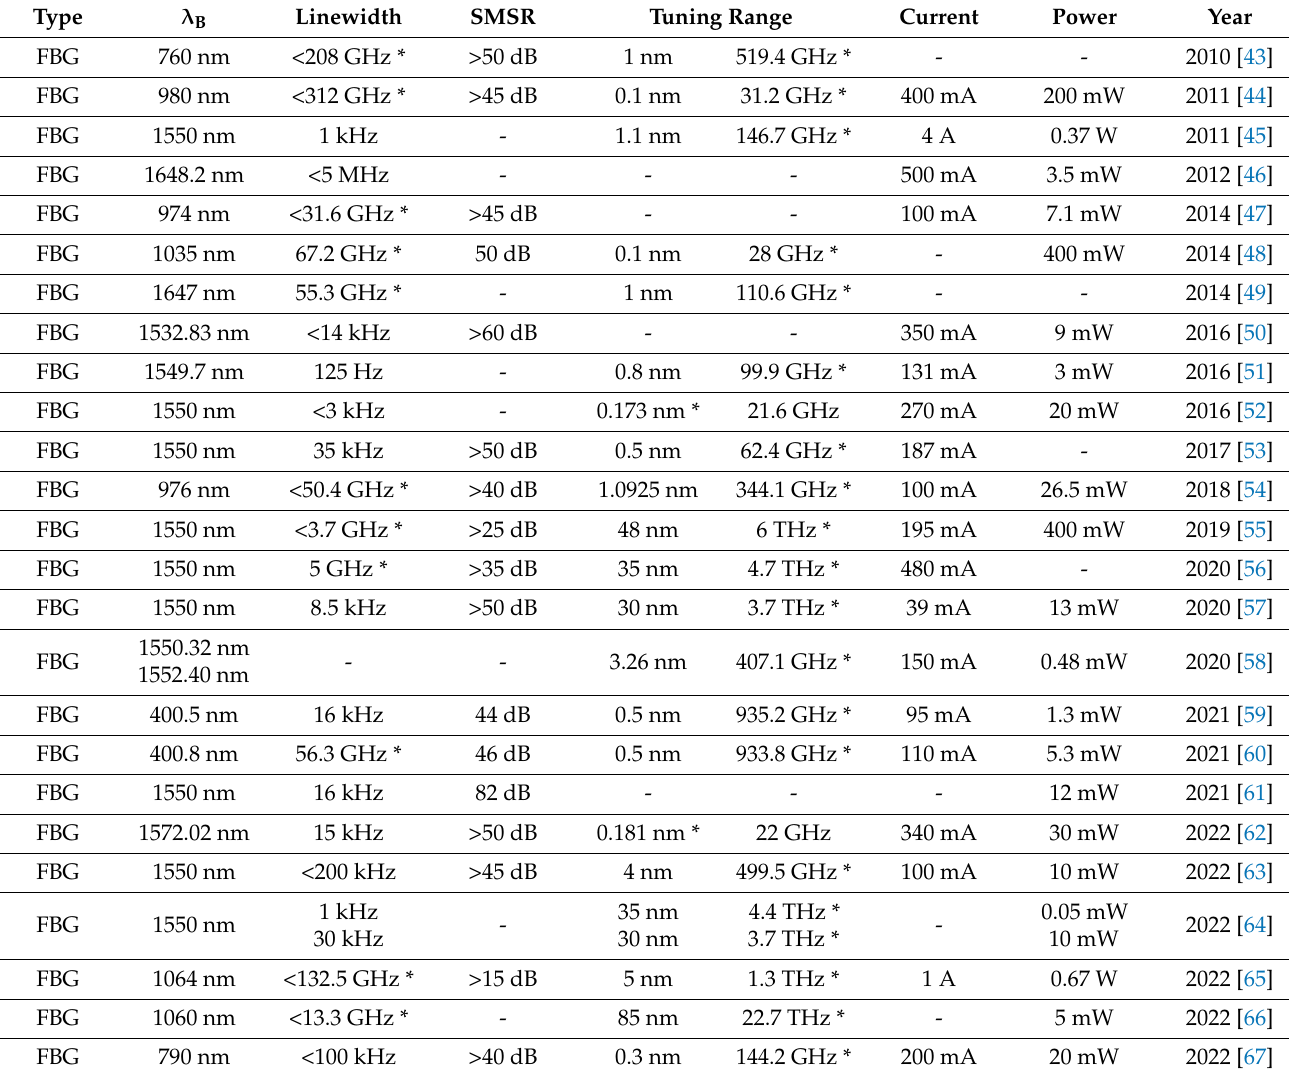
Table 2. The performances parameters of